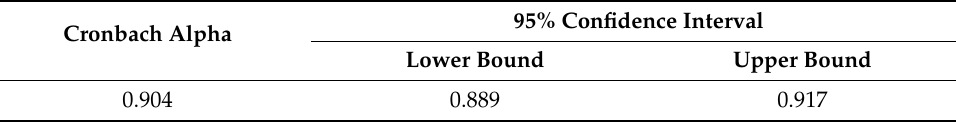
Table 4. Confidence interval for Cronbach Alpha.